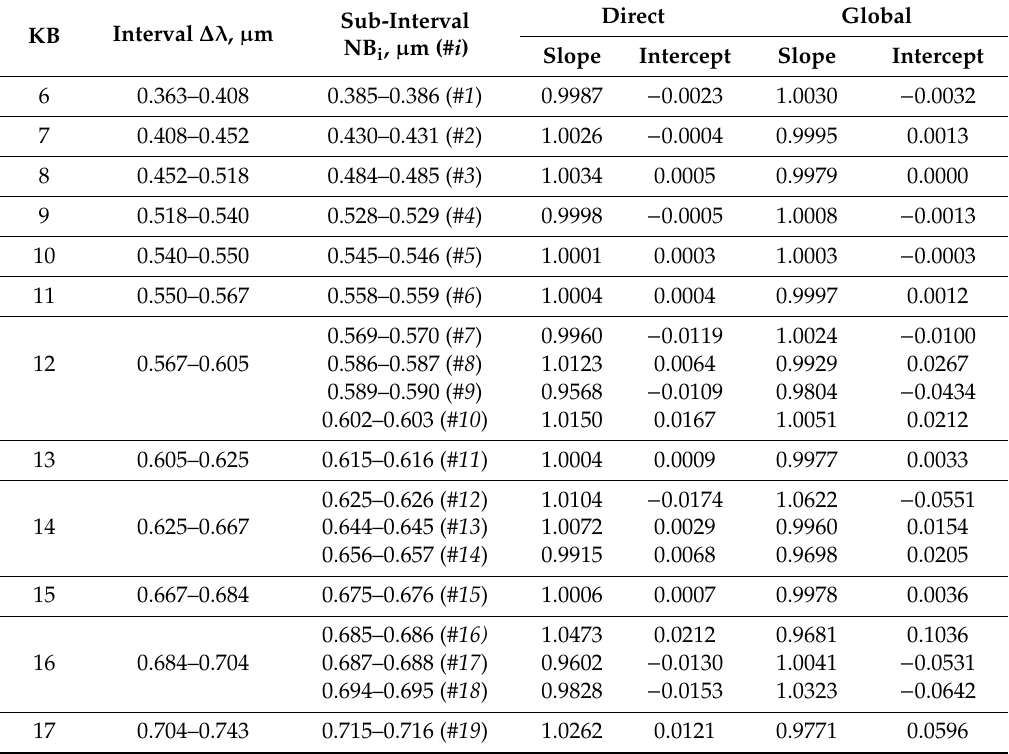
Table 2. The spectral intervals i.e. Kato bands (KBs) of the Kato et al. [26] scheme and sub-intervals i.e. narrow bands (NB i ) used for the resampling technique. The intercepts and slopes of the a ffi ne functions to infer the transmissivity over NB i from the transmissivity over